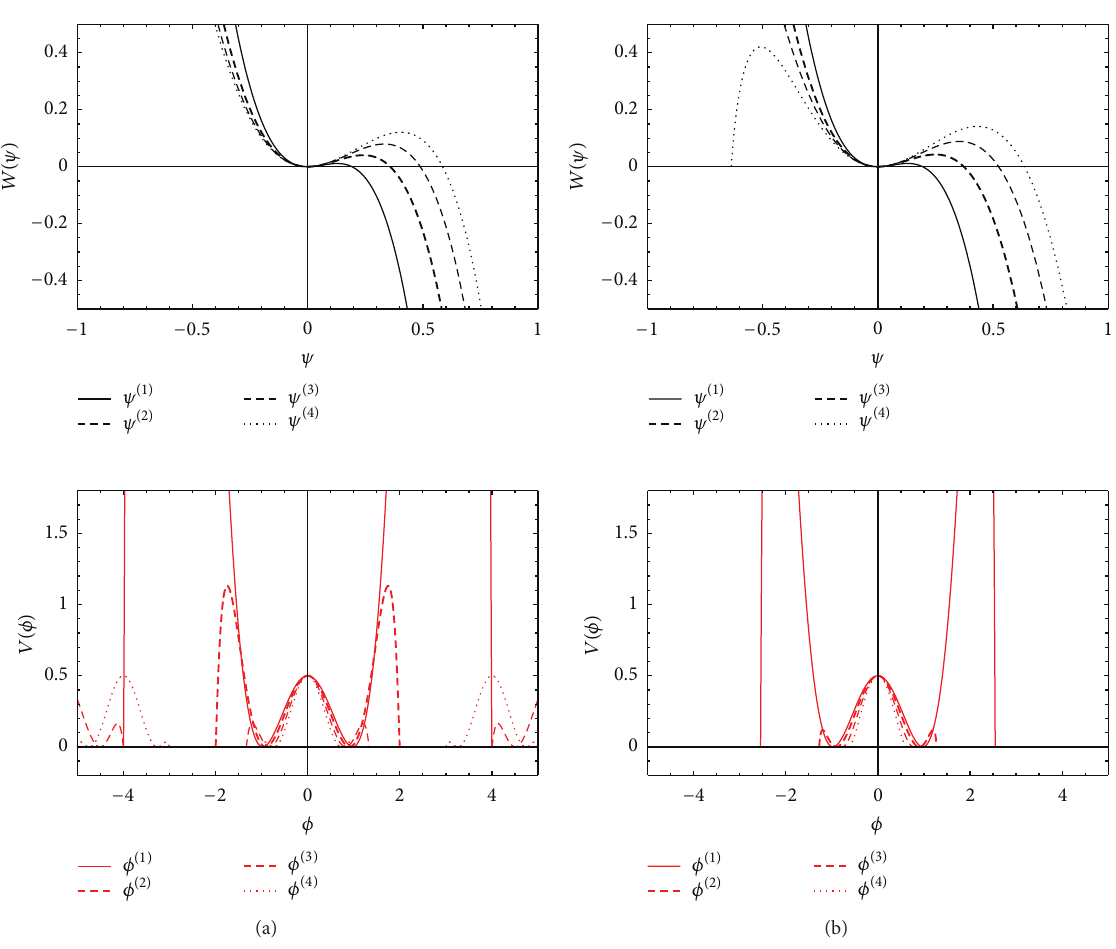
Figure 4: The 3 -cyclica deformed potentials obtained from hyperbolic (first column) and trigonometric (second) deformation functions. The legend parameters are in correspondence with those of first and second columns from Figure